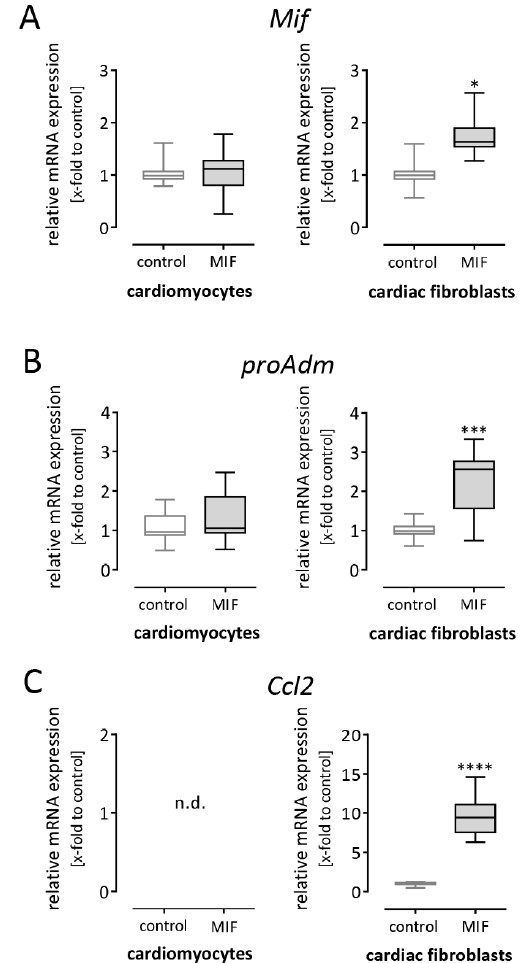
Figure 4. Recombinant MIF stimulates pro-inflammatory response in cardiac fibroblasts but not in cardiomyocytes. Cardiomyocytes and cardiac fibroblasts were stimulated with 50 ng/mL recombinant MIF for 24 h followed by gene expression analysis. ( A ) After MIF stimulation, cardiomyocytes did not alter the gene expression of Mif , whereas in cardiac fibroblasts MIF stimulation in turn increased the gene expression of Mif and may amplify its effects. ( B ) The expression of proAdm was not significantly increased in cardiomyocytes but in cardiac fibroblasts. ( C ) The pro-inflammatory chemokine Ccl2 was not detectable in cardiomyocytes. In contrast, cardiac fibroblasts respond to MIF stimulation with highly increased Ccl2 expression. Gene expression levels are shown as relative mRNA expression (x-fold to control cells) using the formula 2 − ∆∆ Ct and presented in box plots (min to max). Gene expression data represent three independent experiments, each performed in 6–12 replicates. * significantly different compared with untreated cells as control; * p < 0.05; *** p < 0.001; **** p < 0.0001; n.d. not detectable.